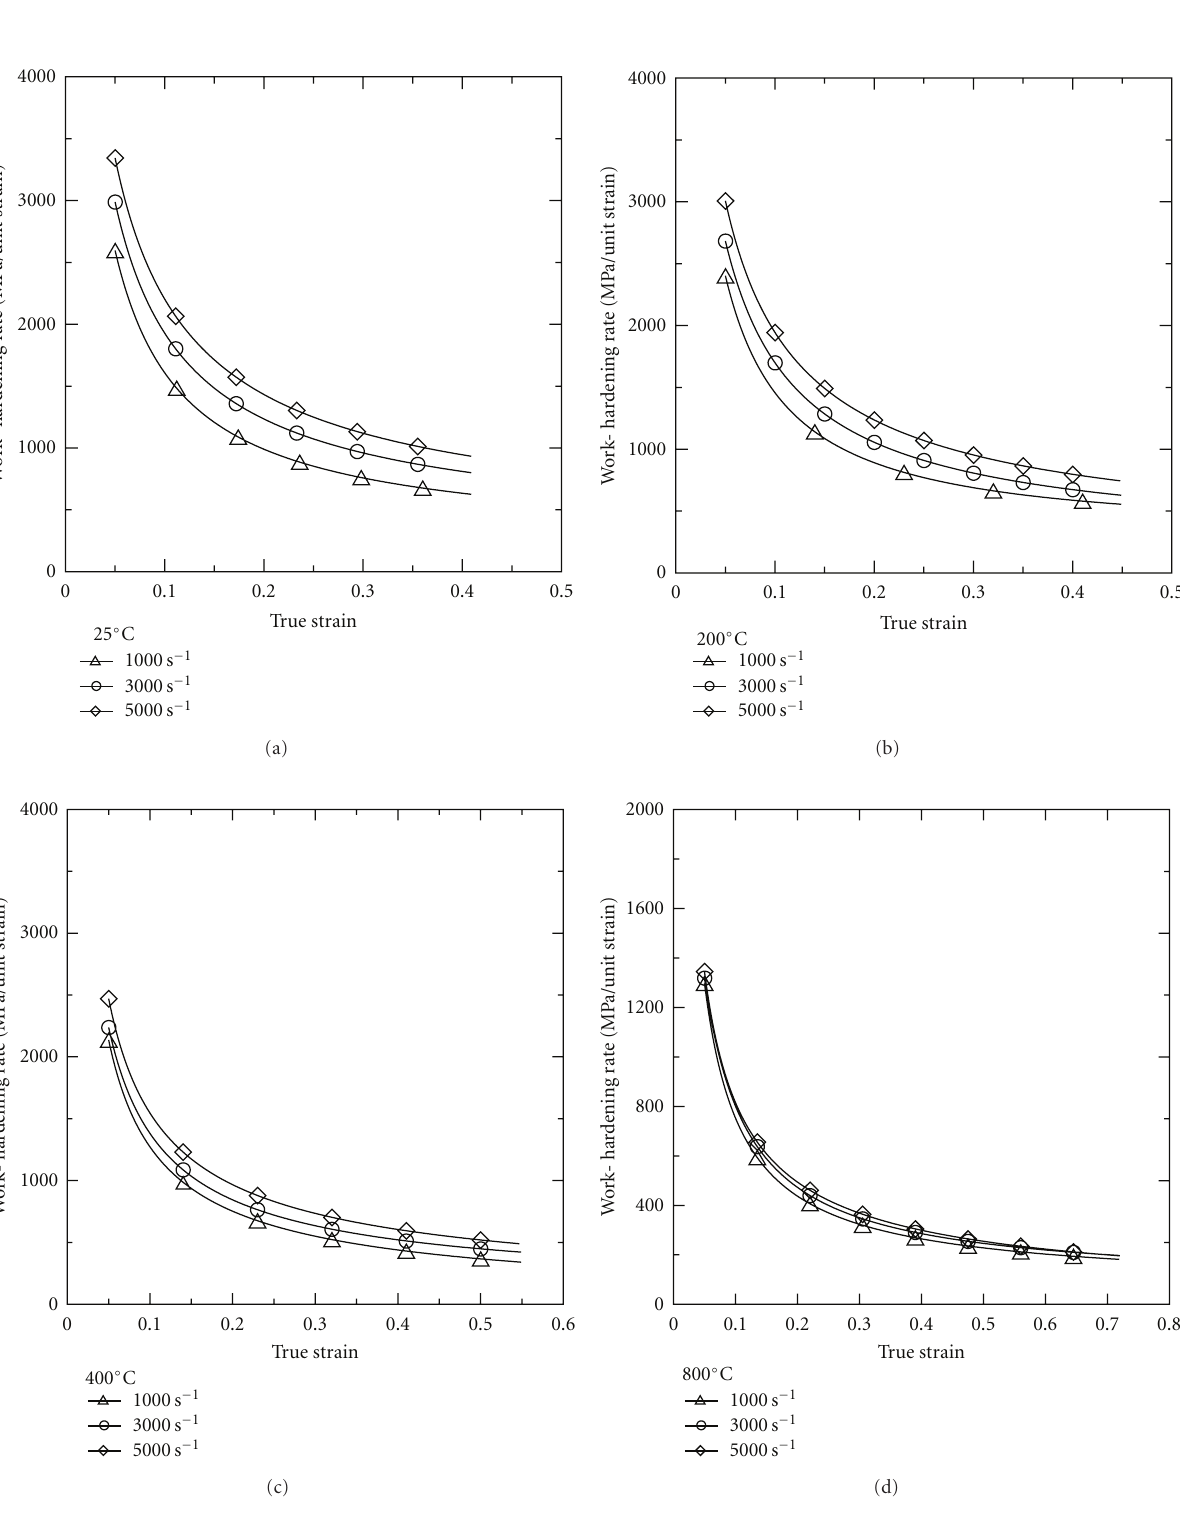
Figure 4: Work-hardening rate of 316L stainless steel deformed at di ff erent strain rates and temperatures of (a) 25 ◦ C; (b) 200 ◦ C; (c) 400 ◦ C; (d) 800 ◦